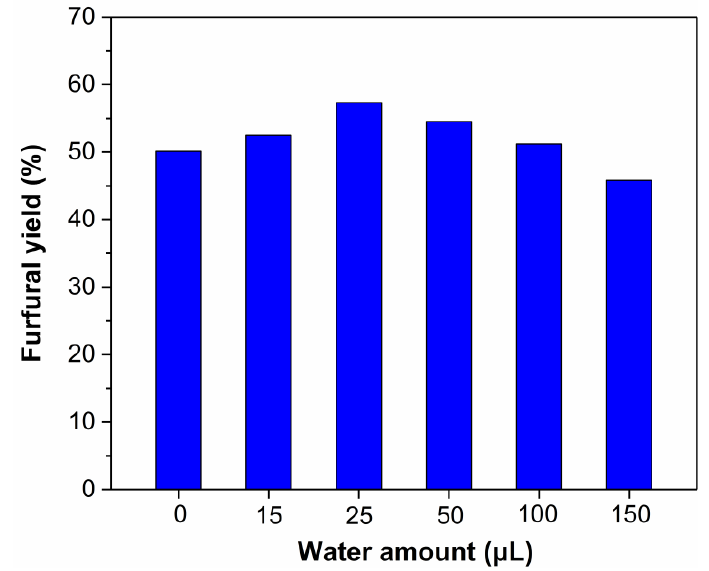
of SnCl 4 :monosaccharide = 1: 10; 130 ◦ C; 1 h.